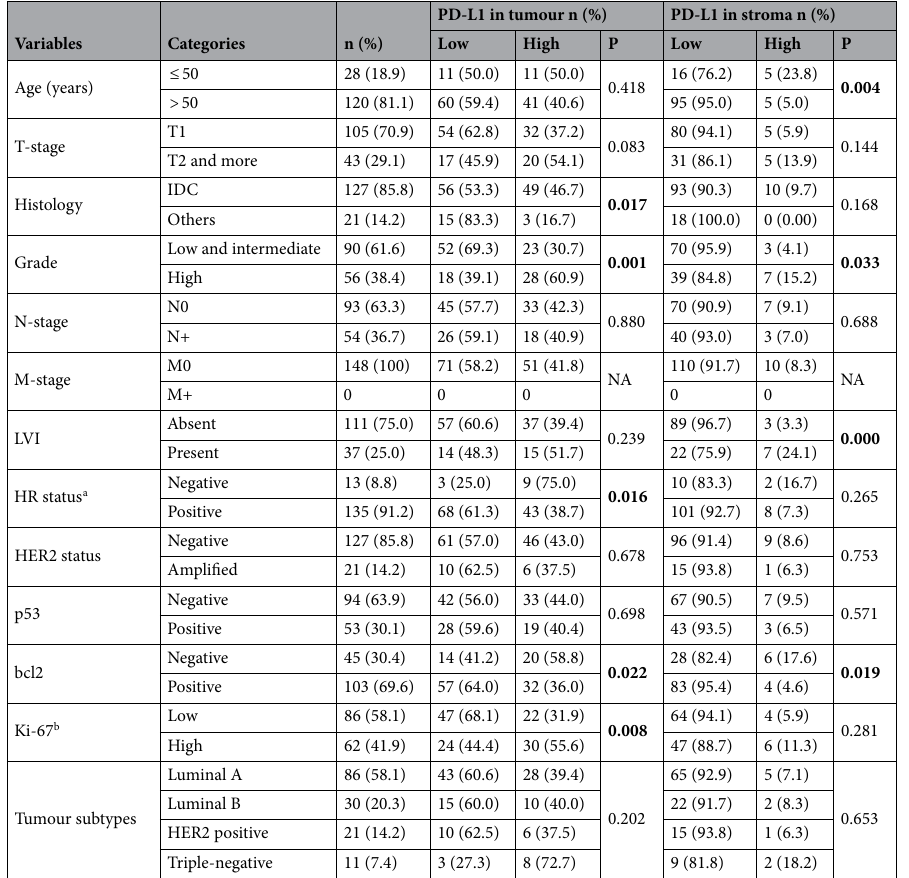
Table 1. PD-L1 expression in relation to clinical characteristics of patients. The number of analysed samples for individual measured variables from the total number of 148 enrolled patients is shown in the table. Significant results are highlighted in bold. IDC, invasive ductal carcinoma; LVI, lymphovascular invasion; HR, hormonal receptor. a Negative for both or positive for either with cut-off 1%. b Cut-off